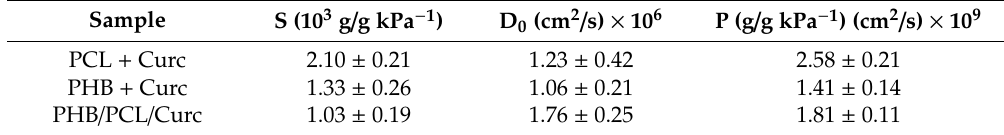
Table 2. Sorption, di ff usion and permeability coe ffi cients of electrospun mats.